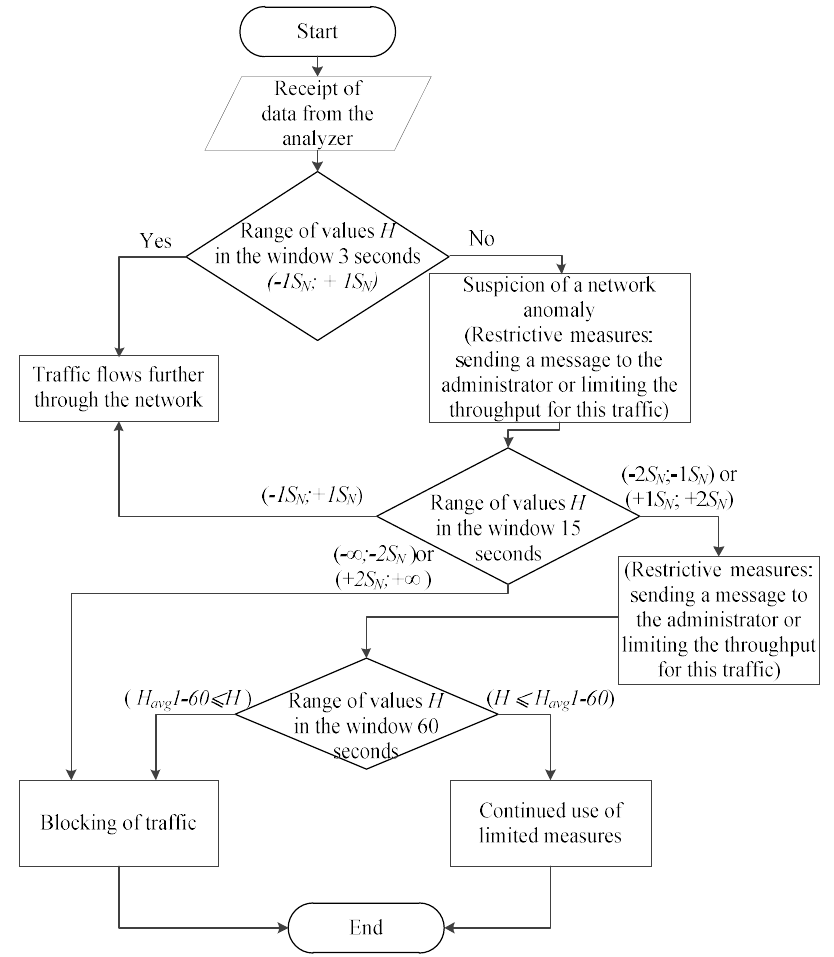
Figure 4. Block diagram of the detection algorithm in terms of the "Regulator" component operation.